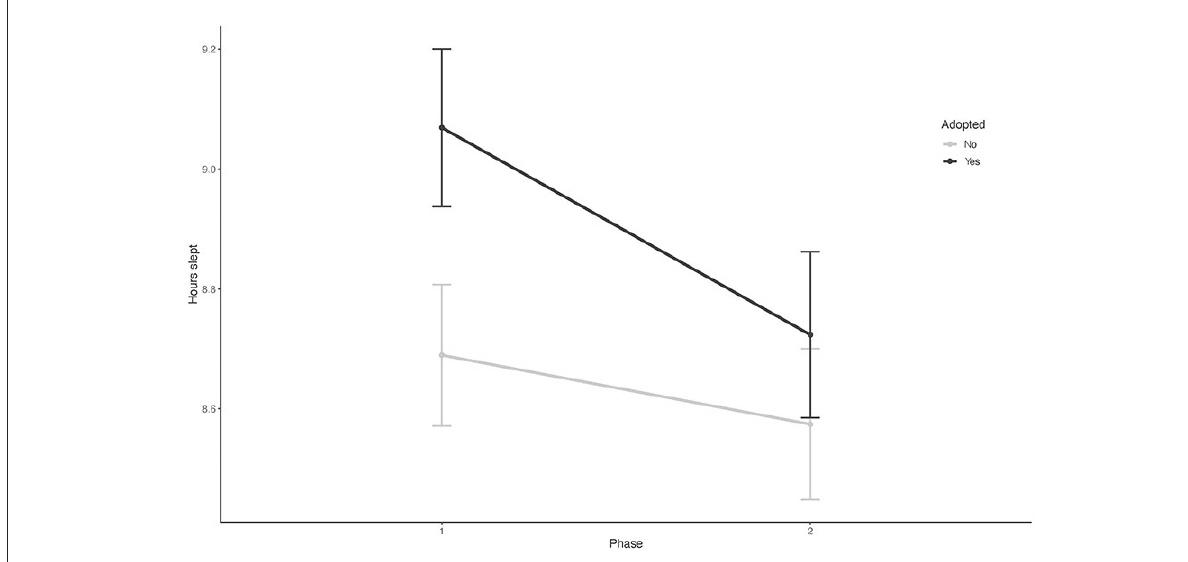
FIGURE1 The mean trajectories for sleep duration in 24h in the study population over the study recordings (Phase 1 and Phase 2).